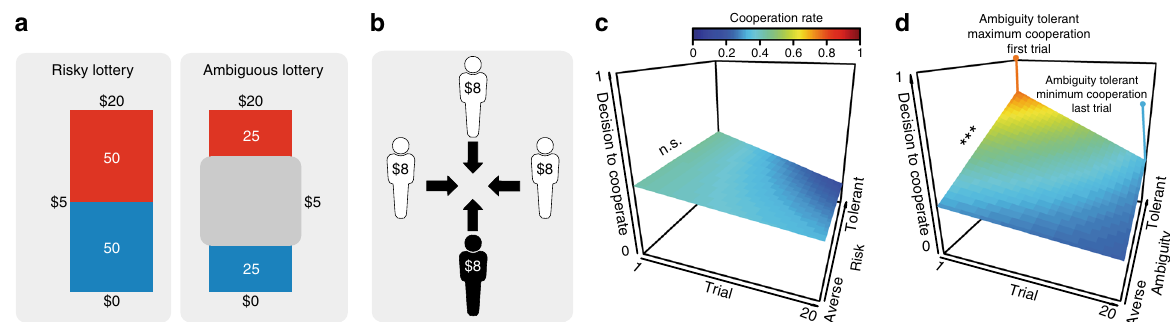
Fig. 1 Experiment 1 task structure and results. Subjects fi rst completed a computerized gambling task, which consisted of bags fi lled with 100 red and blue poker chips — denoted by a red and a blue bar. a The left panel represents a risky lottery with 50% chance of winning $20, while the right panel is an example of an ambiguous lottery where 50% of the chips are occluded. Subjects could always choose between playing the lottery or getting a sure payout of $5. b In the PGG, each player was endowed with $8 and had to decide to contribute to a common pool or keep the entire $8 for themselves. Money contributed to the pool was doubled and split equally amongst all players. c A regression reveals risk attitudes (even when accounting for feedback presented over the task) do not modulate decisions to cooperate. d In contrast, ambiguity-tolerant individuals are more willing to cooperate with others, and this relationship is modulated by receiving feedback over time. The surfaces represent regression planes that were calculated by extracting the predicted values from each regression, where 1 indicates full cooperation and 0 indicates full defection. Asterisks indicate signi fi cant differences (*** p